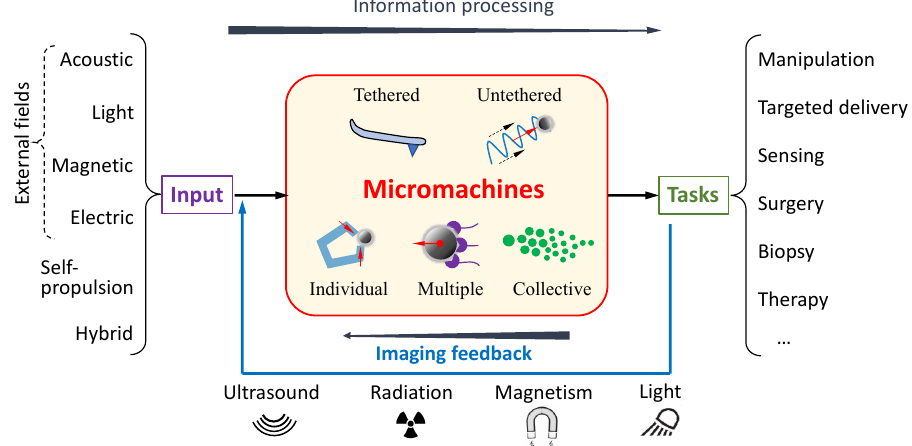
Figure 1. Schematic illustration of a typical imaging-guided micromachine